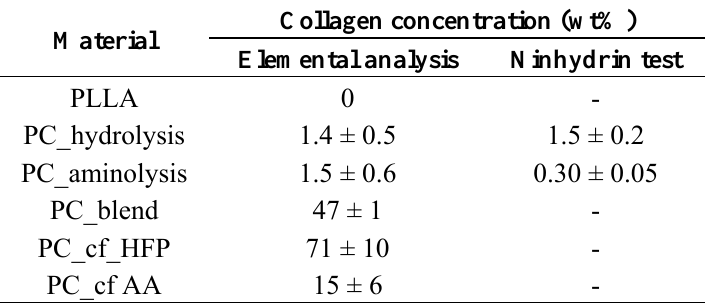
Table 3. Means and standard deviations of collagen (wt%) inserted into the scaffolds obtained from elemental analyses and the ninhydrin